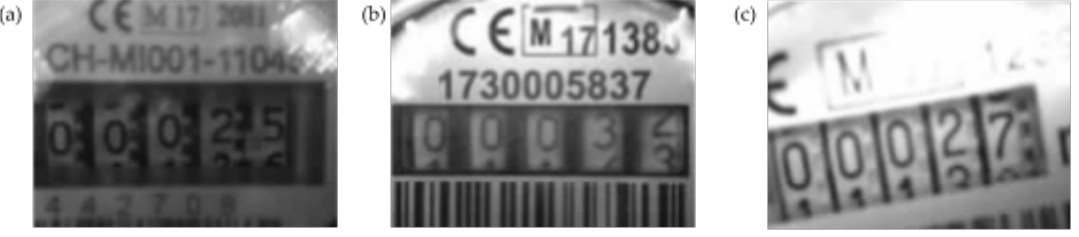
Figure 14. Different radials example. Dumb Meter 1 ( a ) Dumb Meter 2 ( b ) Dumb Meter 3 ( c